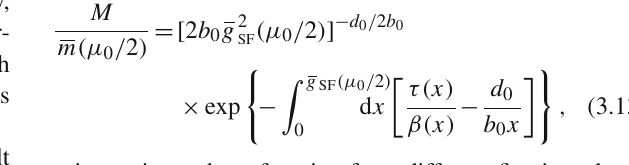
tends to provide a better description of our data. Anyway,